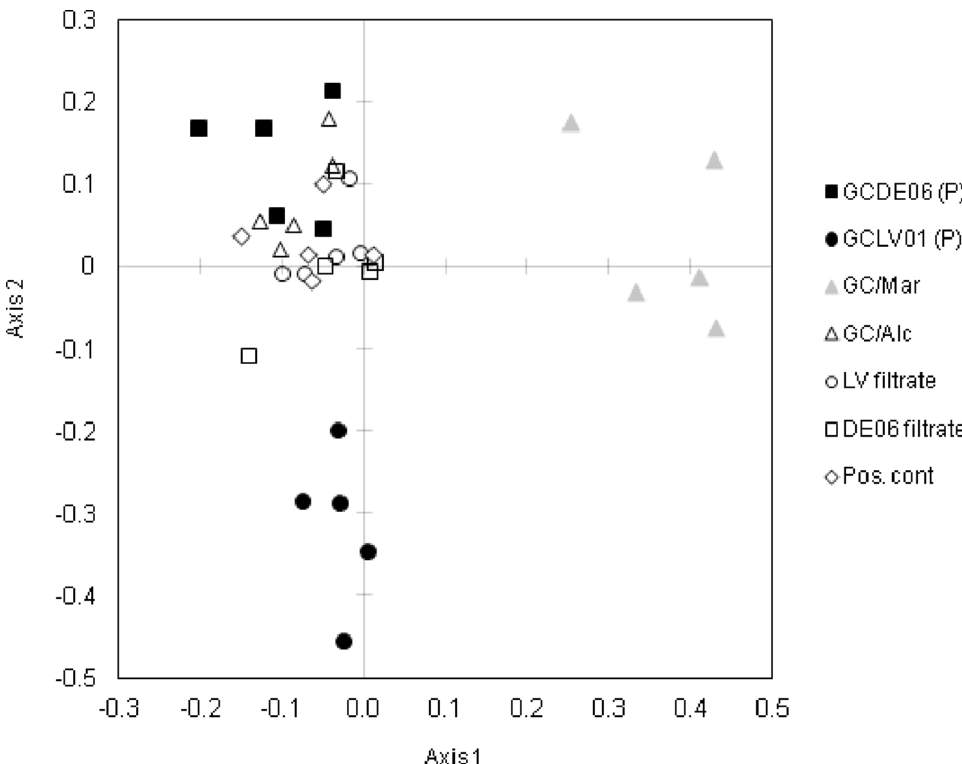
Figure 6. Canonical discriminant analysis of principal coordinates of toxin profiles of G.catenatum parent and offspring cultures.